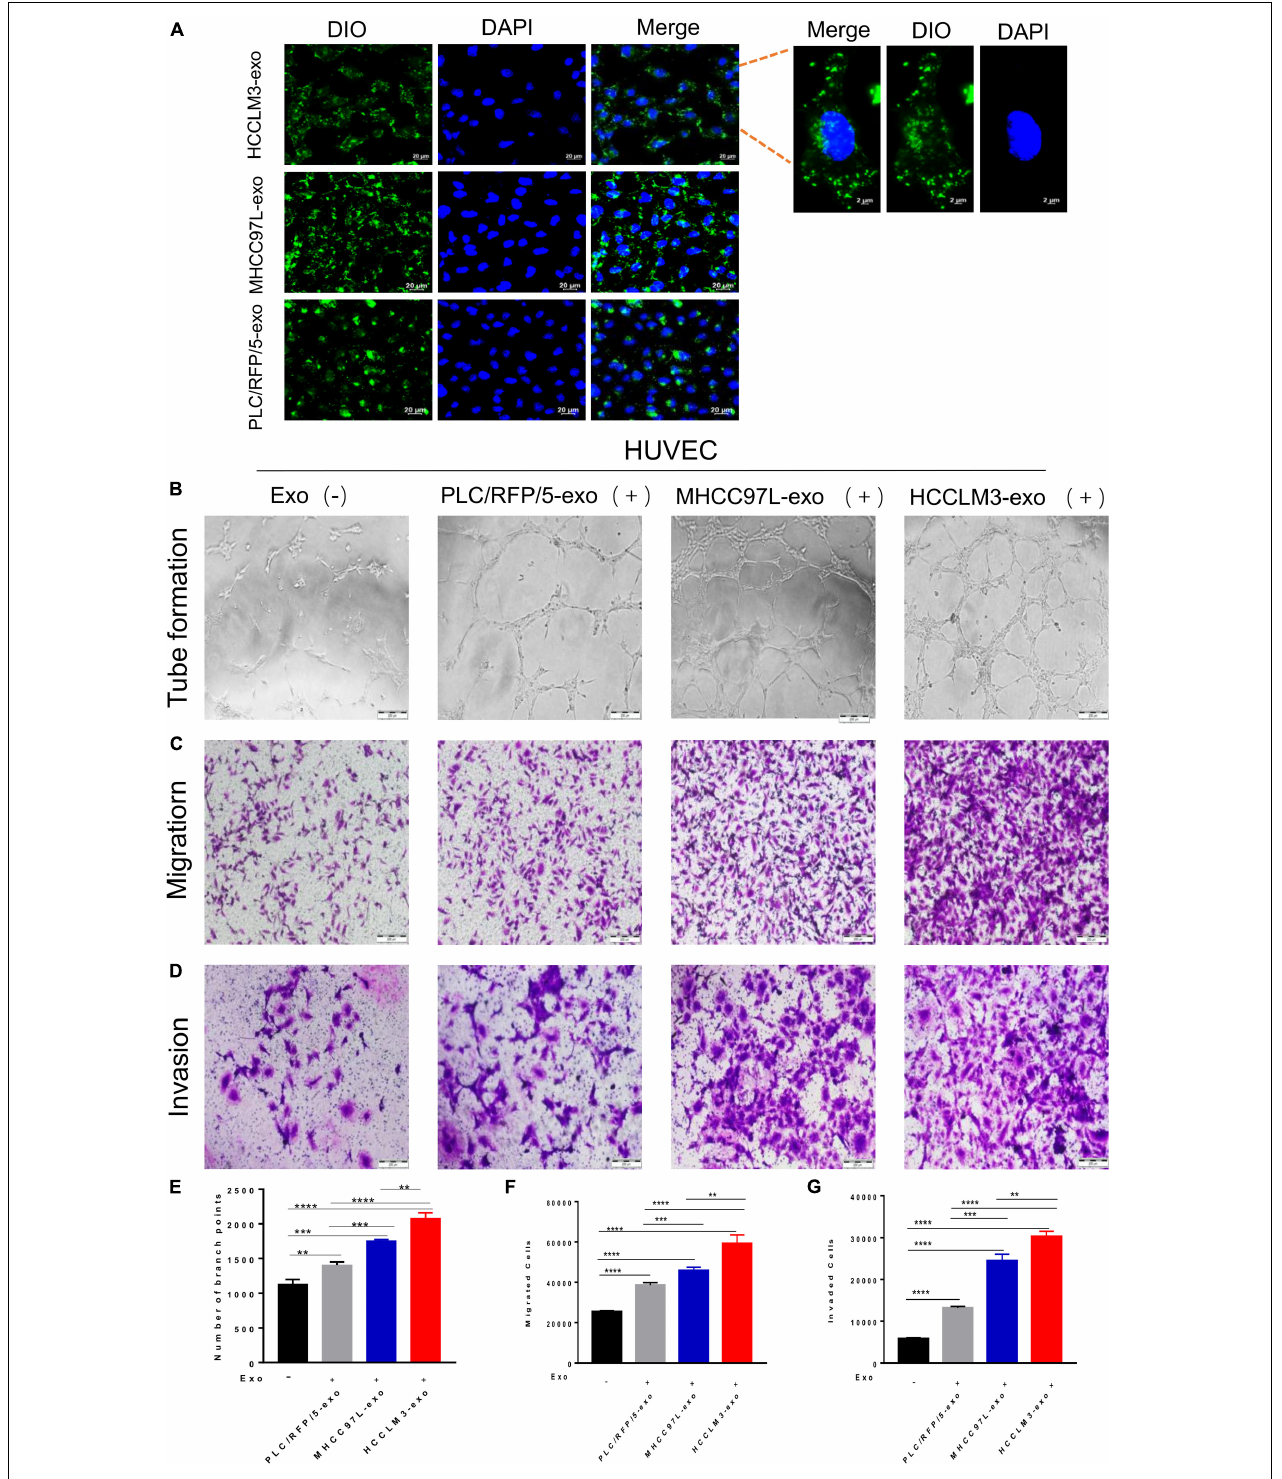
FIGURE 2 | HCC exosomes promoted HUVECs tube formation, migration, and invasion in vitro and this effect increases with increasing metastatic potential of HCC cells. (A) Confocal imaging showed the delivery of Dio-labeled exosomes (green) to DAPI-labeled HUVECs (blue) and representative images were presented. Scale bar, 20 µ m. (B–D) Tube formation assays (B) , migration assays (C) , and invasion assays (D) of HUVECs treated with equal quantities of exosomes derived from different liver cancer cells or blank control. Scale bar, 200 µ m. (E–G) Each experiment was performed three times independently and results were analyzed with ImageJ software. (* p < 0.05; ** p < 0.01; *** p < 0.001; **** p < 0.0001).